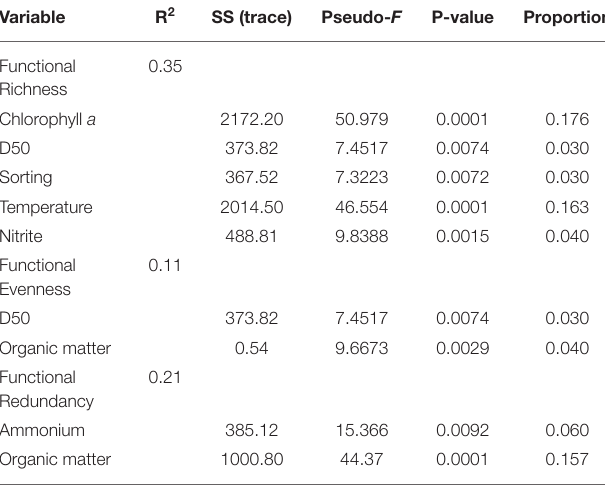
TABLE 6 | Result of DISTLM forward analysis.